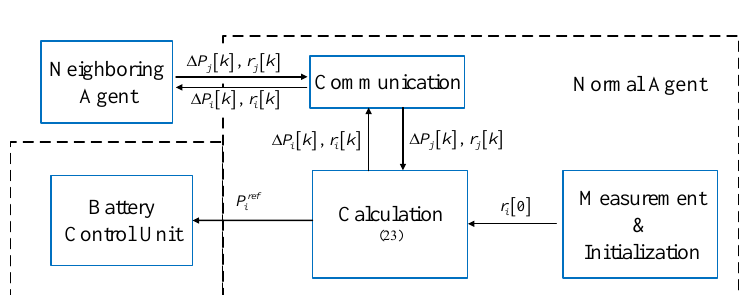
Figure 4. Leader agent block.